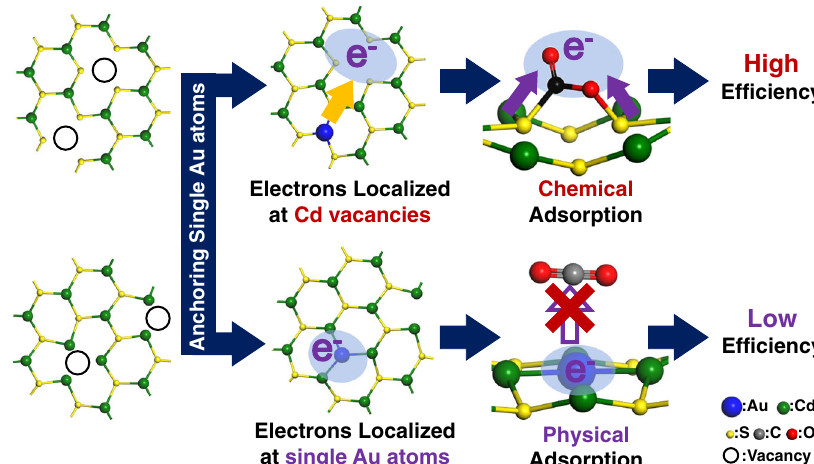
Fig. 1 Photocatalytic mechanism. Schematic illustration of single Au atoms in CdS to promote CO 2 photoreduction.